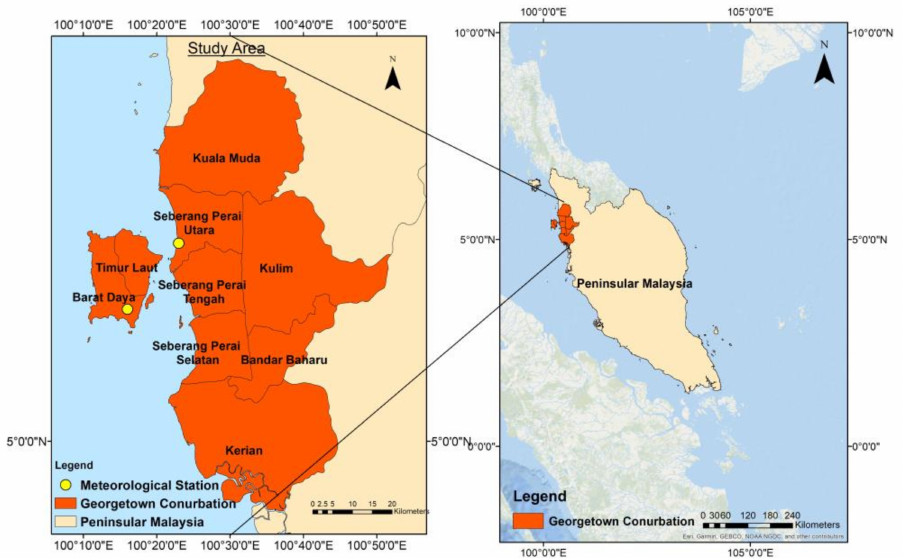
Figure 2. The location of the George Town Conurbation